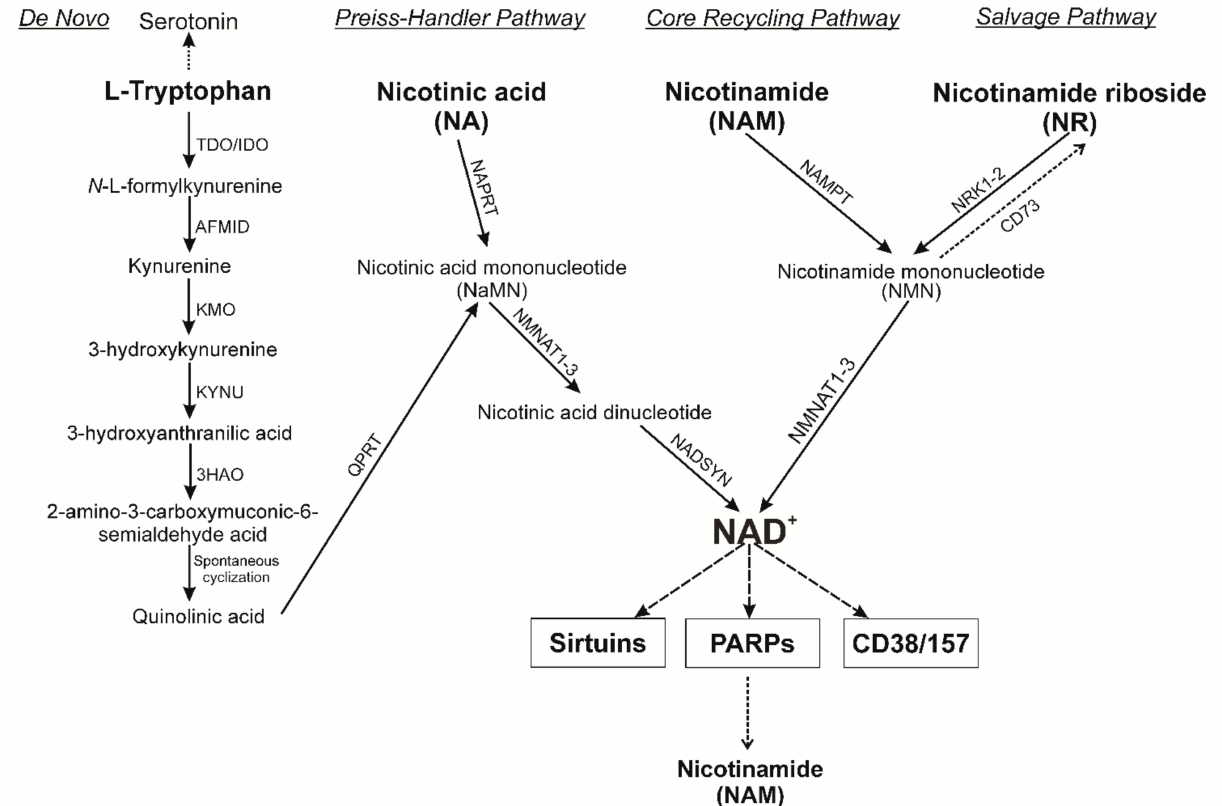
Figure 2. NAD + biosynthetic pathways. De novo biosynthesis begins with the conversion of tryptophan (Trp) to N -L-formylkynurenine either by indolamine-2,3-dioxygenase (IDO) or tryptophan-2,3-dioxygenase (TDO). After four reaction steps, N -L-formylkynurenine can subsequently be converted to the unstable 2-amino-3-carboxymuconate-6- semialdehyde acid, which can undergo nonenzymatic cyclization to quinolinic acid. The last step of de novo biosynthesis consists of the quinolinate-catalyzed phosphoribosyltransferase (QPRT) formation of NA mononucleotide (NaMN) us- ing PRPP (5-phosphoribosyl 1-pyrophosphate). The Preiss-Handler pathway is initiated by NA phosphoribosyltransferase (NAPRT) to form NaMN. Further, NAMN is converted into adenine dinucleotide NA (NAAD) by the enzymes NMN adenylyltransferase (NMNAT1-3) together with ATP. Finally, NAAD is converted to NAD + via an amidation reaction catalyzed by the enzyme NAD + synthase (NADSYN). The Core Recycling and Salvage Pathways are the shortest ways to synthesize NAD + from NAM and NR (2 steps). NAM is converted by the rate-limiting nicotinamide phosphoribosyltrans- ferase (NAMPT) to form NMN using PRPP as a cosubstrate. NMN is also a product of NR phosphorylation by NR kinases (NRK1-2). The subsequent conversion of NMN to NAD + is catalyzed by the NMNAT1-3 enzymes. Further, the synthesized NAD + is used in the work of such enzymes as sirtuins, PARPs, CD38/157. NR, nicotinamide riboside; NAM, nicotinamide; NMN, NAM mononucleotide; AFMID, kynurenine formamidase; KMO, kynurenine 3-monooxygenase; KYNU,